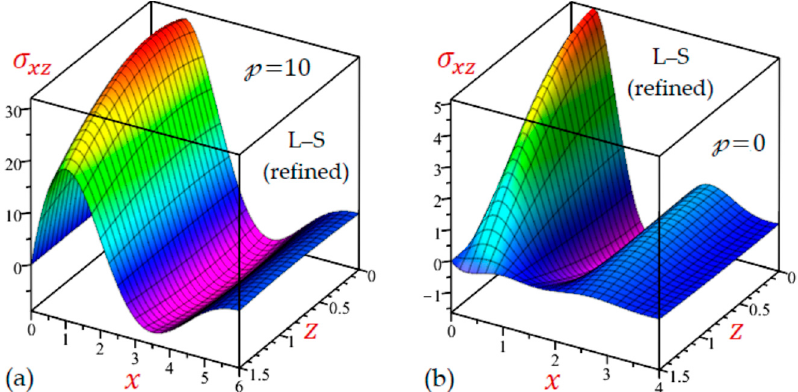
Figure 24. 3D distributions of the transverse shear stress σ xz of the rotating half-space: ( a ) with initial pressure ( 𝓅 = 10 ) and ( b ) without initial pressure ( 𝓅 = 0 ) using the refined L–S generalized